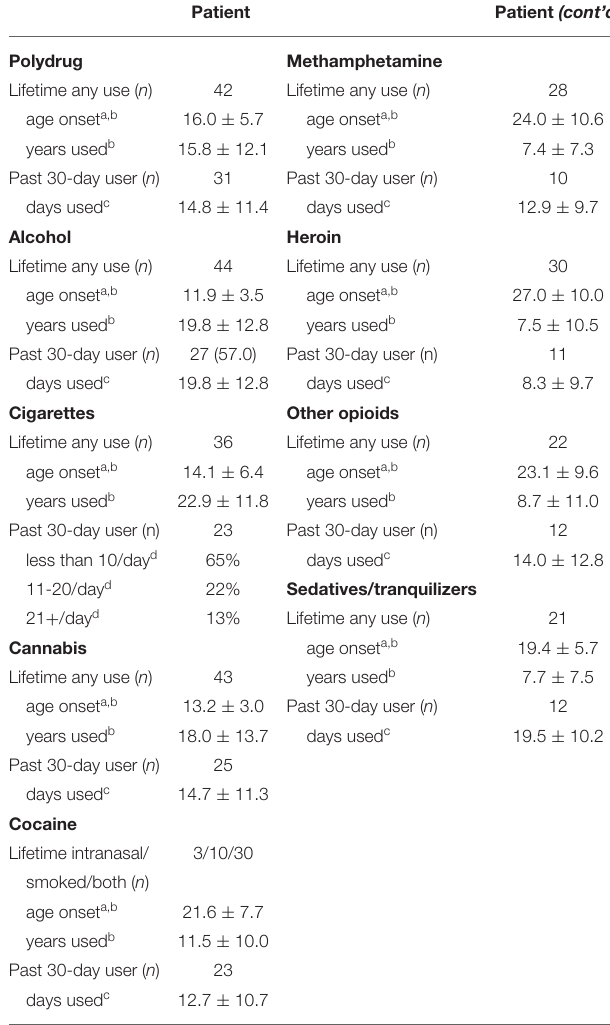
TABLE 1 | Demographic characteristics.